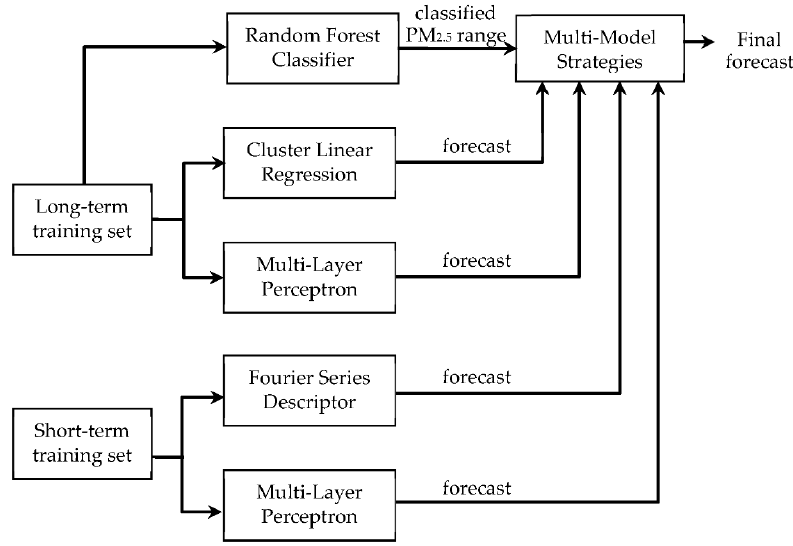
Figure 1. Architecture of our multi-model